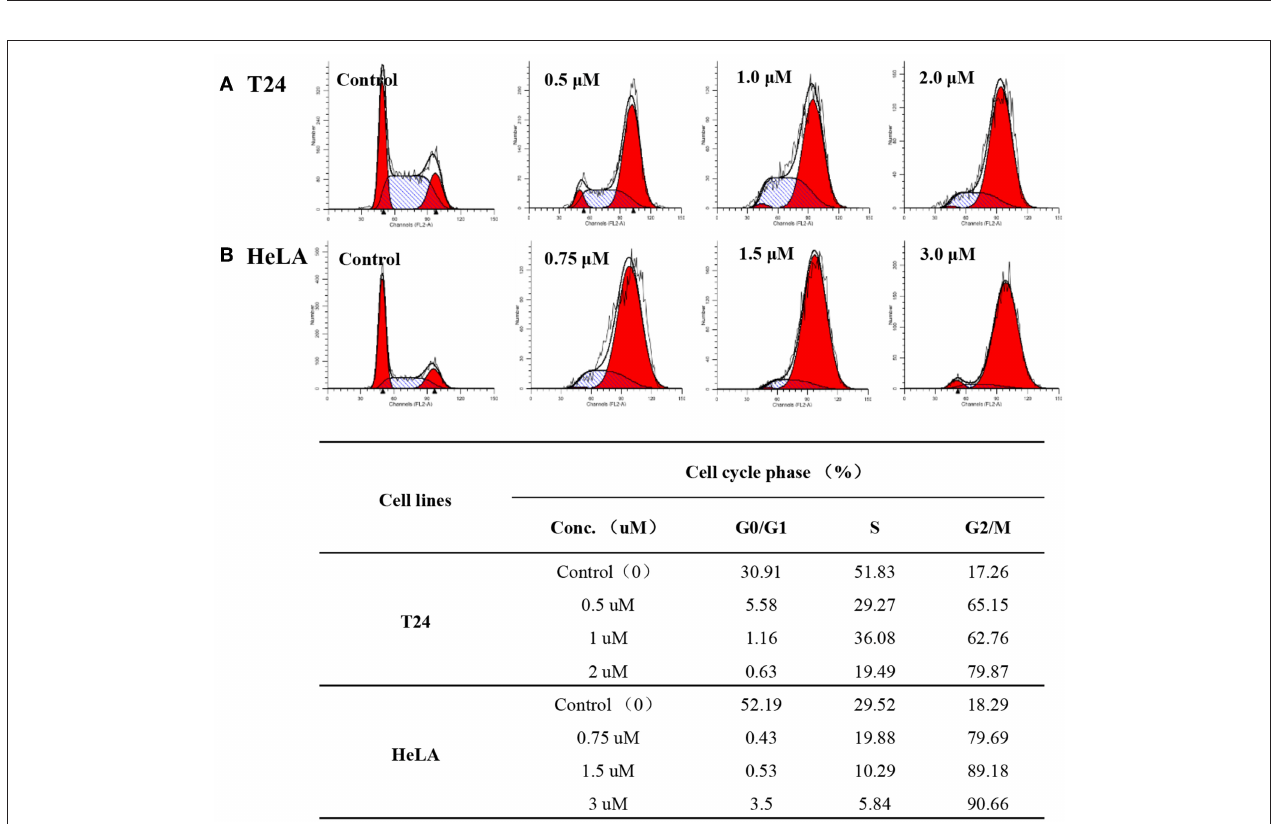
FIGURE 4 | Compound 12g affected the cancer cell cycle distribution at three different gradient concentrations with 0.1% DMSO vehicle as the control. (A) T24 cells treated with 12g for 24h. (B) HeLA cells treated with 12g for 24h.